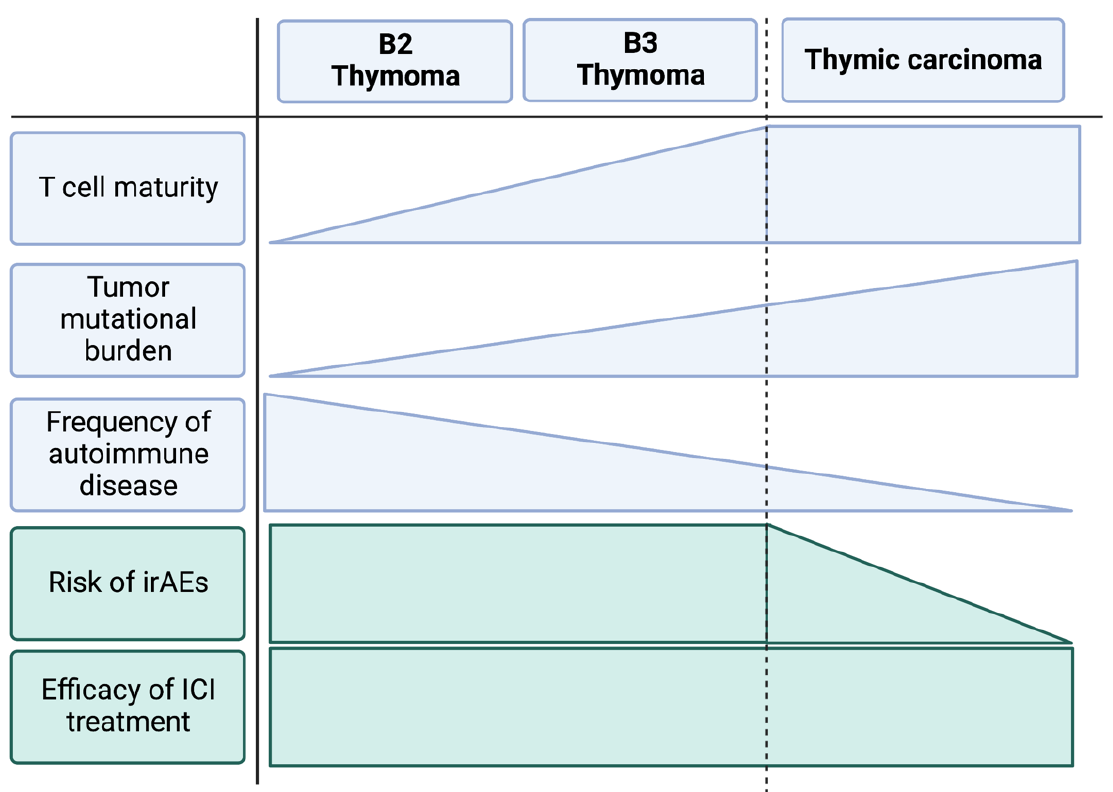
Figure 1. Schematic depiction of tumor characteristics of the most frequent types of advanced thymic epithelial tumors and their relation to irAE risk and efficacy of immune checkpoint inhibitor treatment. We suggest that the higher rate of irAEs in thymoma is related to the intratumoral presence of immature T cells and their association with autoimmune reactions. Thymic carcinoma presents with mature T cell infiltrates and is not associated with autoimmunity. Clinical trials demonstrate a lower risk for irAEs during immune checkpoint inhibition for thymic carcinoma compared to advanced thymoma while reporting a similar efficacy.